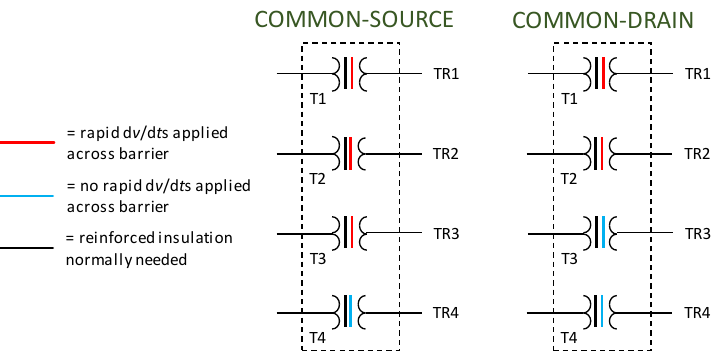
Figure 2. Gate driver power transmission configurations with a single transformer for each device, with CS and CD arrangements.